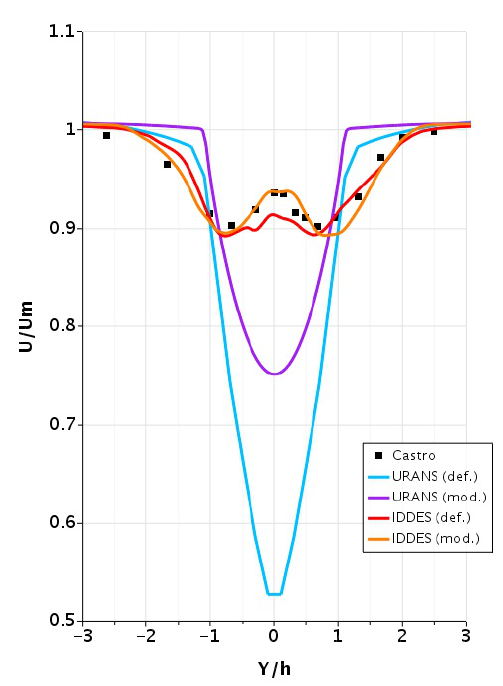
Figure 9. Comparison of Spanwise Mean Velocity along the Symmetry Plane at x / h = 6.5 and z / h =